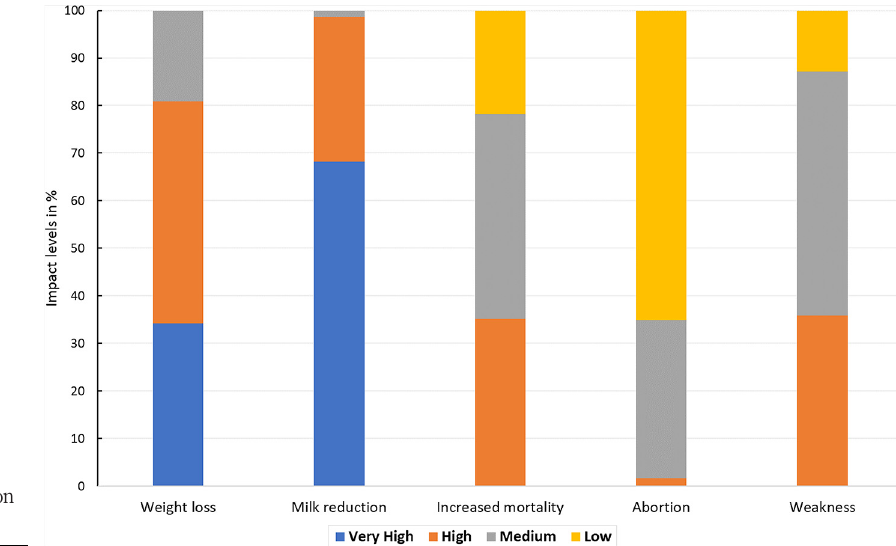
Figure 3. Direct impacts